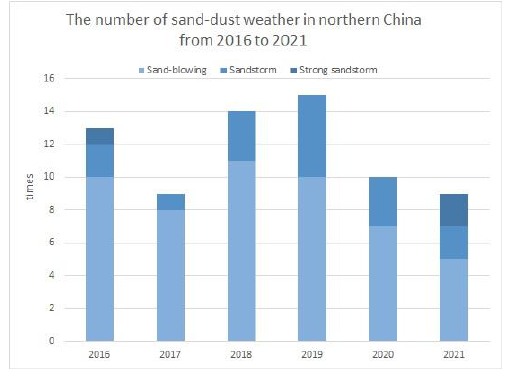
Figure 1. The number of sand-dust weather in northern China from 2016 to 2021